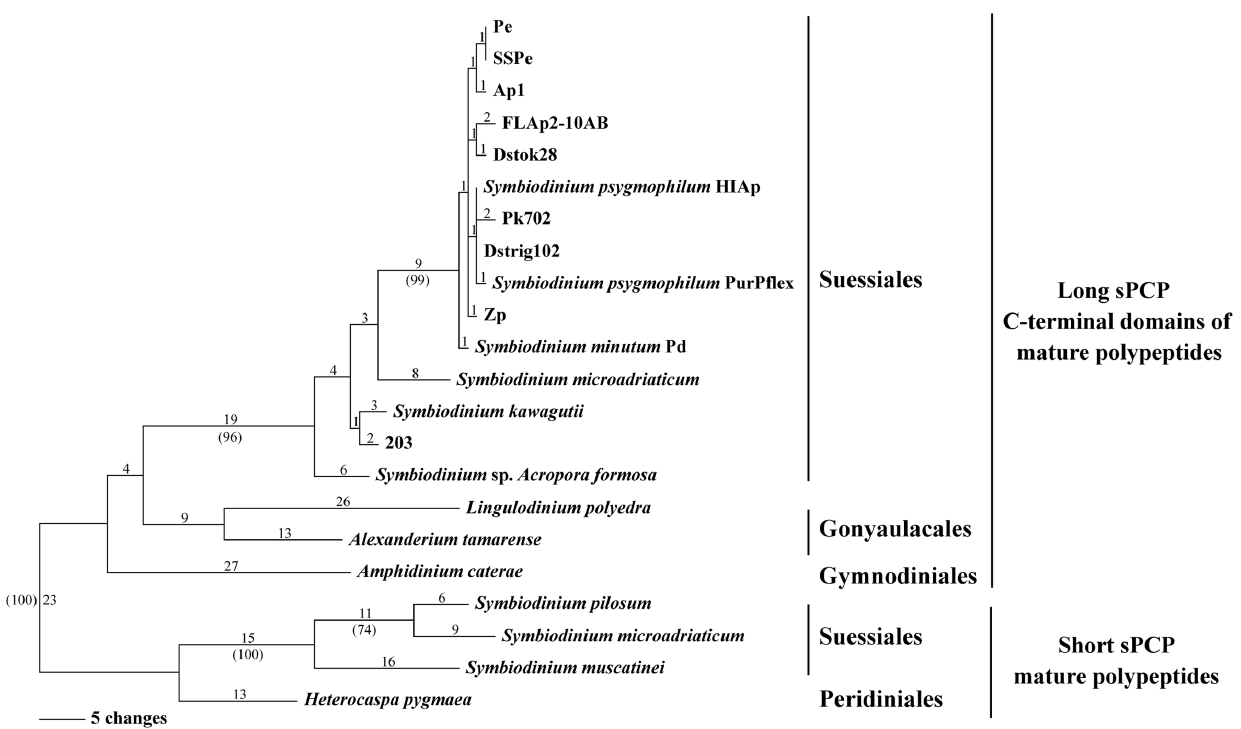
Figure 5. Phylogeny of short and long sPCP predicted amino acid sequences from four dinoflagellate orders. The most parsimonious tree shows unambiguous resolution of short and long sPCP sister clades. Branch lengths are shown above the branches. Support values . 70% based on + 1000 bootstrap trees are shown in parentheses below branches. The long sPCP genes were produced from fusion of duplicated short sPCP genes that occurred once early during the evolution of peridinin-containing dinoflagellates. Thereafter, short and long sPCP genes and corresponding polypeptides diverged.